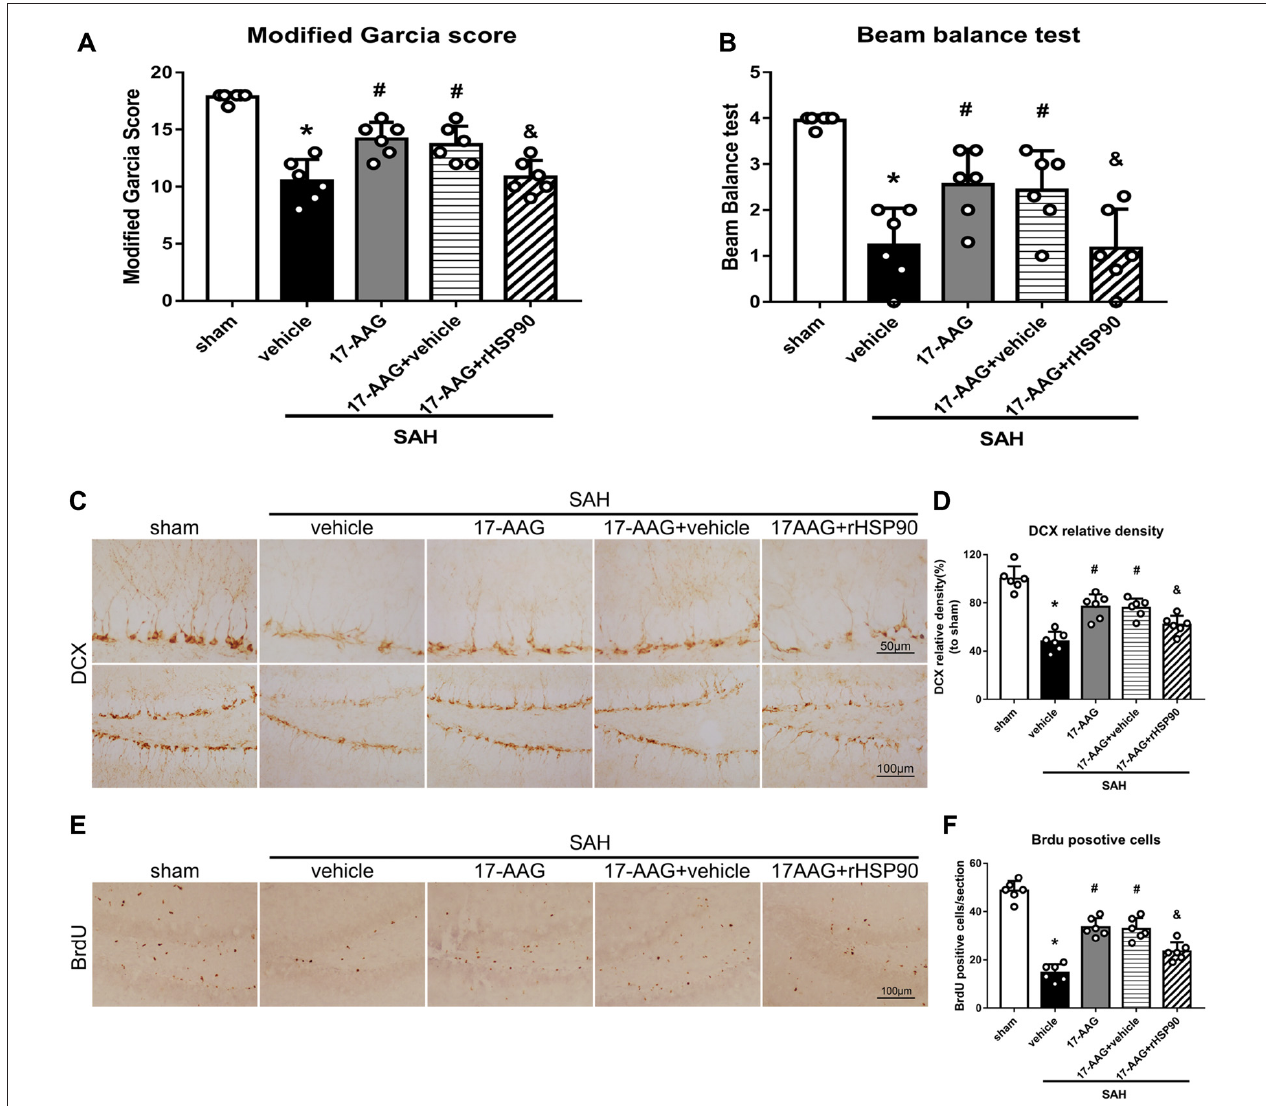
FIGURE 6 | Effects of 17-AAG and rHSP90 on neurobehavior and neurogenesis 48 h after SAH. (A) Modified Garcia scores and (B) beam balance test scores; n = 10 per group. (C) Immunohistochemistry staining and (D) quantitative analyses of DCX in the left hemisphere. (E) Immunohistochemistry staining and (F) quantitative analyses of BrdU in the left hemisphere; n = 4 per group. ∗ P < 0.05 vs. sham; # P < 0.05 vs. SAH + vehicle; & P < 0.05 vs. SAH + 17-AAG + vehicle. The error bars represent